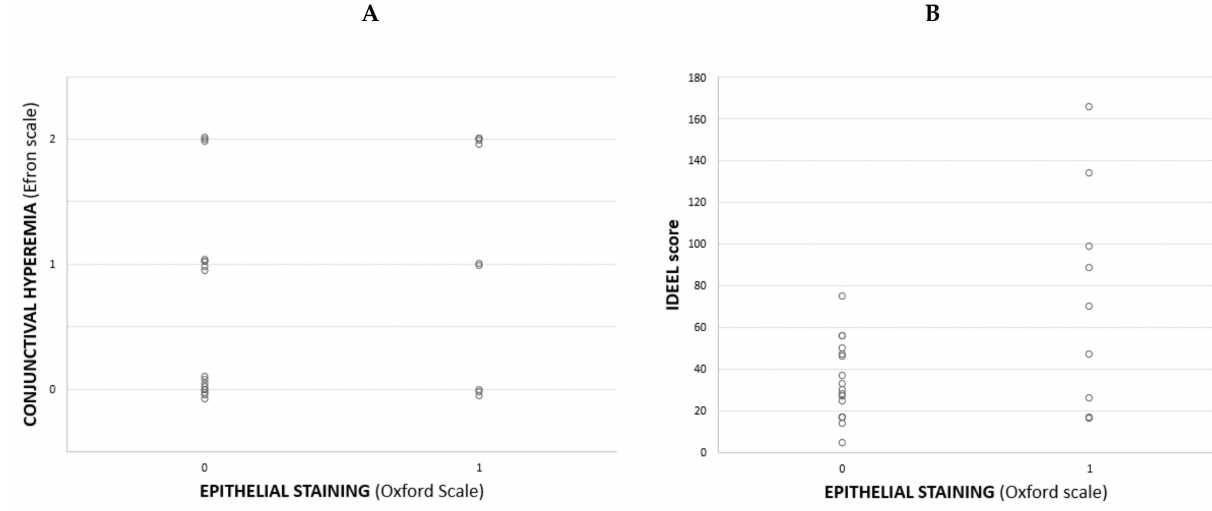
Figure 1. ( A ). Scatterplot of epithelial staining vs. conjunctival hyperemia in eyes receiving tra- beculectomy ( r = 0.55, p = 0.01); ( B ). Scatterplot of epithelial staining IDEEL, Impact of Dry Eye